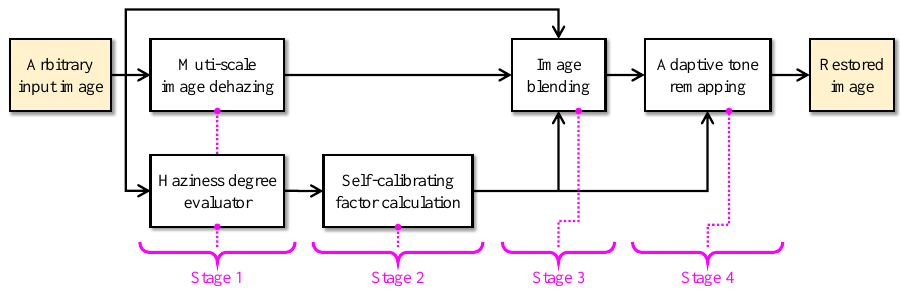
Figure 5. Illustration of a naive parallelization of the autonomous dehazing